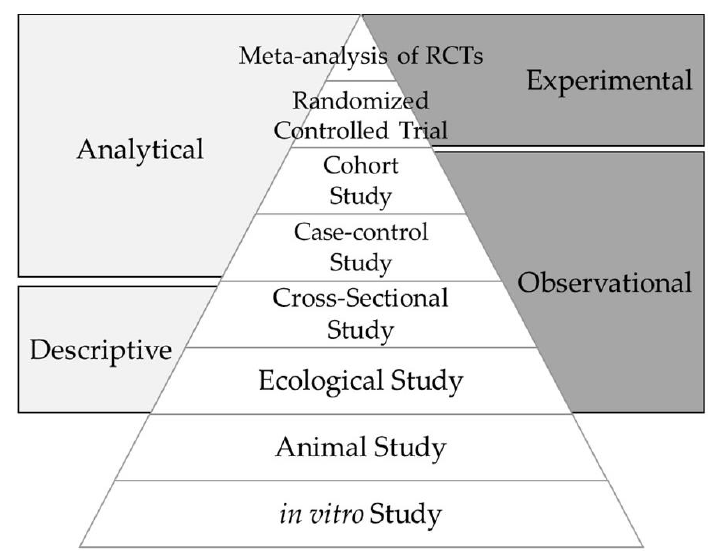
Figure 1. The hierarchy of evidence, increasing from the base of the pyramid to the gold standard for establishing causality.